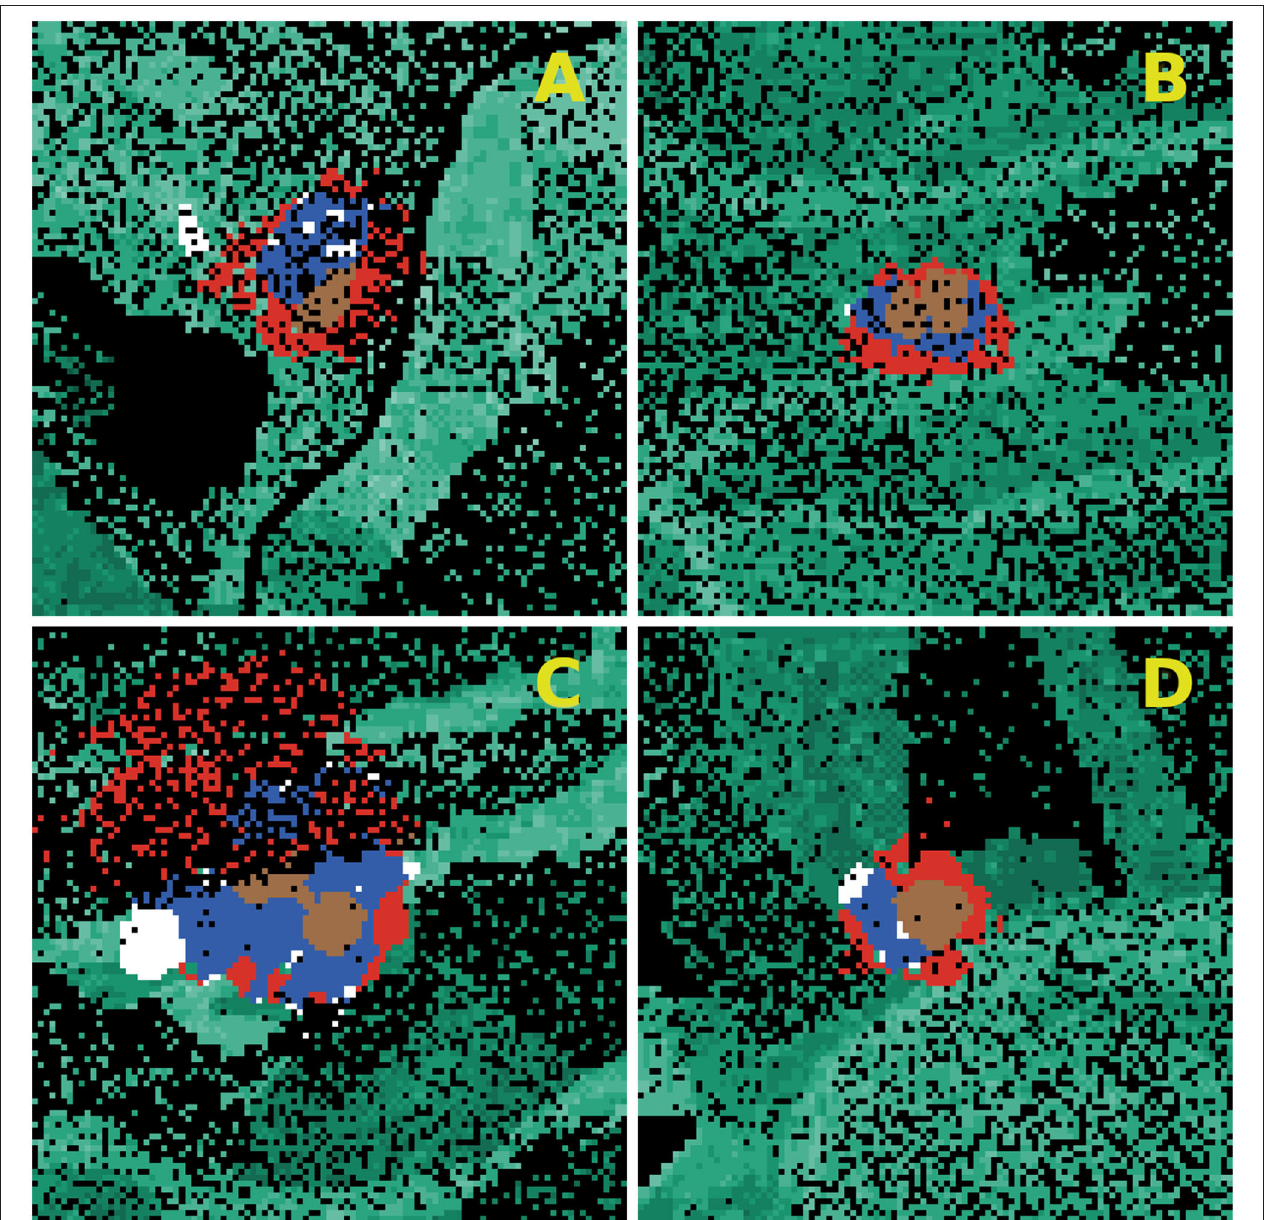
FIGURE 4 | Simulation results for the fitted parameter combinations on the four research sites (A–D) . The values for beetle energy, wind speed, and beetle swarming duration are the same on each research site while the values of wind direction and beetle generation amount are taken from the best fits during random sampling. The corresponding parameter values and prediction errors can be found in Table 7 . Brown, beetle source trees; red, trees infested only in the model; white, trees infested only in reality; blue, trees infested in the model matching the real world data; green, spruce trees; black, everything else (e.g., other tree species, meadow,